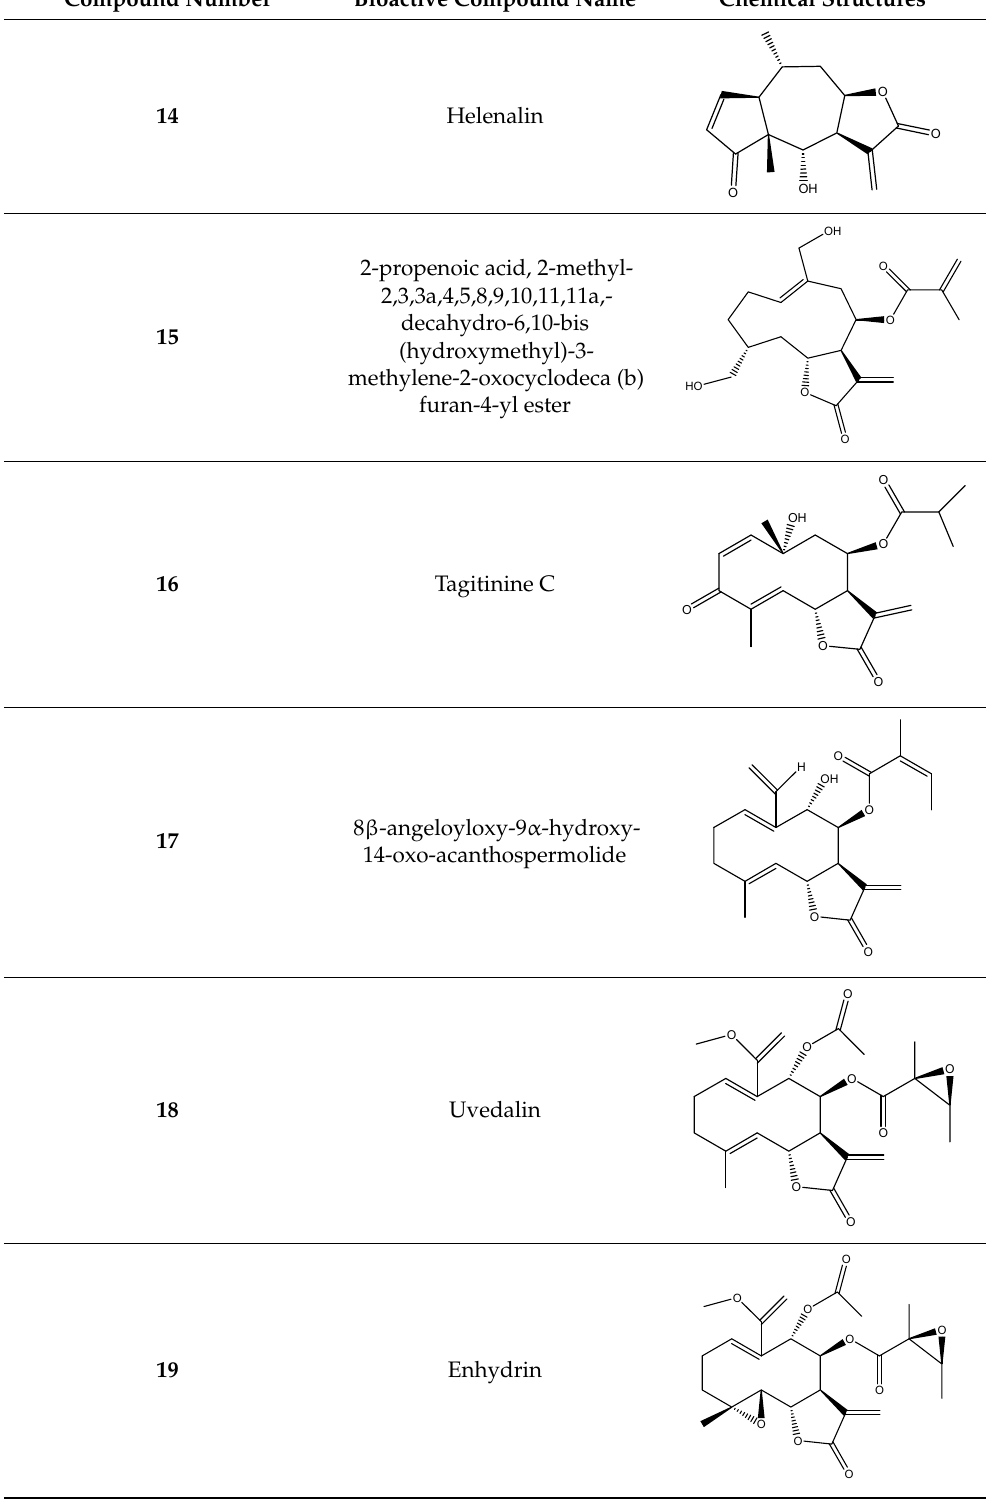
Table 2. Bioactive sesquiterpene lactones tested in PDAC models. Compound